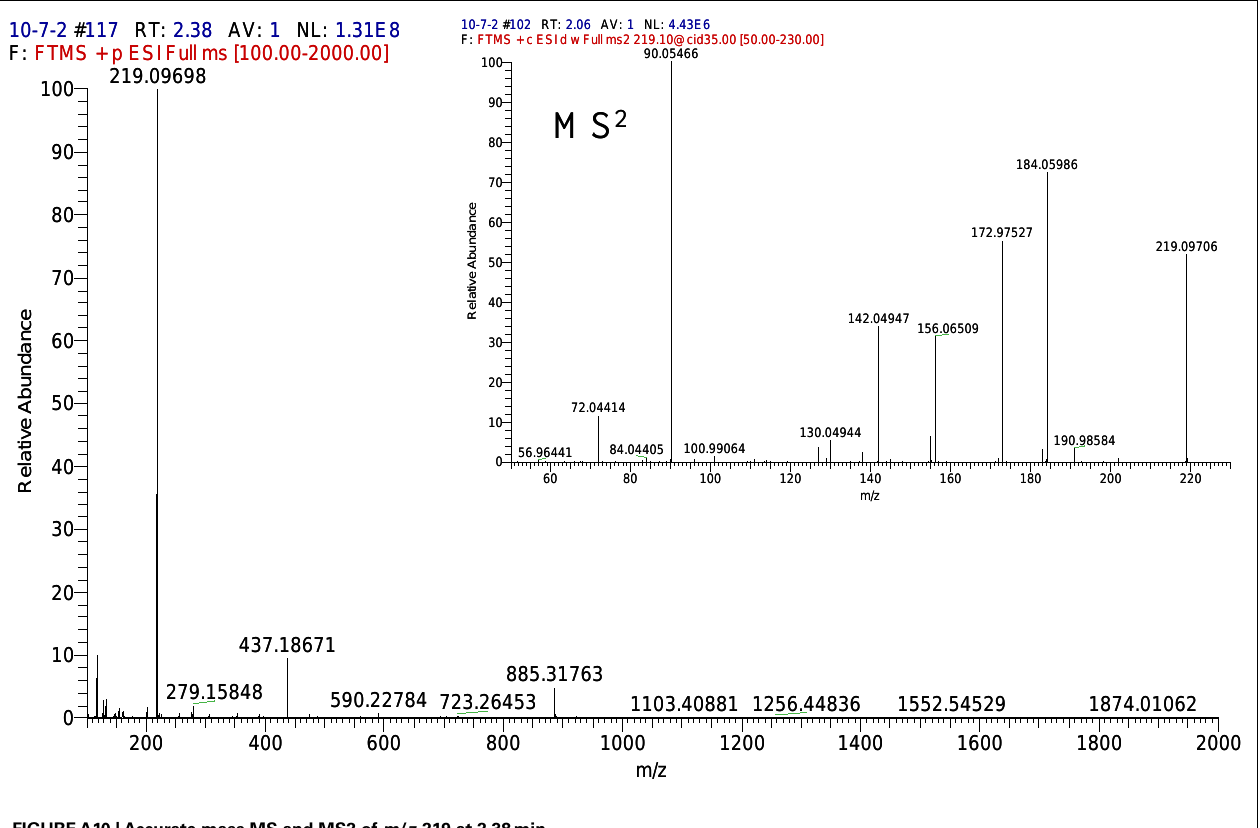
FIGUREA10 |Accurate mass MS and MS2 of m / z 219 at